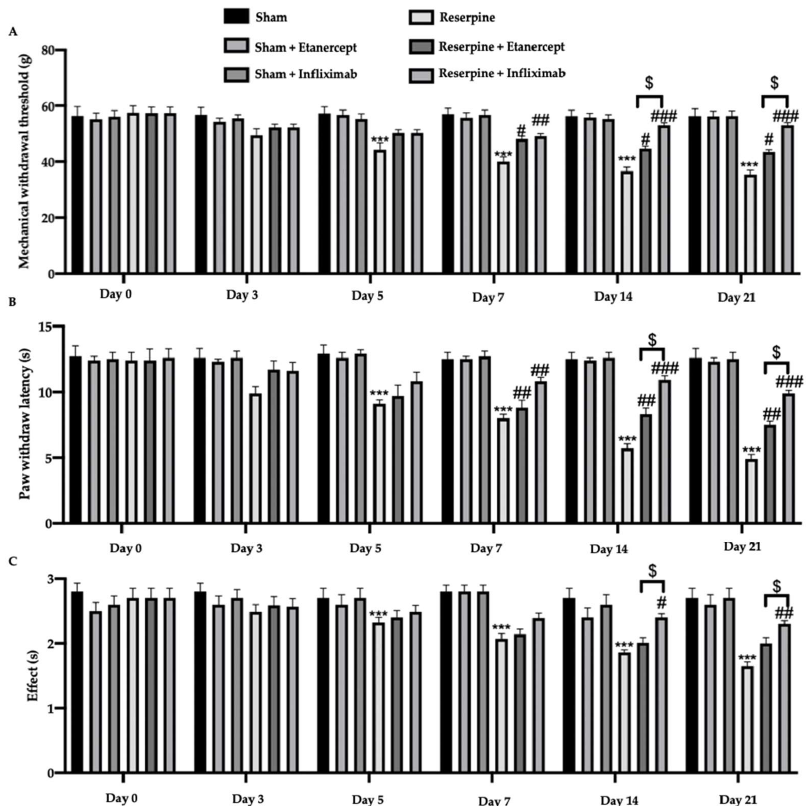
Figure 2. Efficacy of etanercept and infliximab administration on behavioural changes reserpine induced. Behavioural test: ( A ) Von Frey test, ( B ) hot plate test, ( C ) tail-flick test. For these analyses n = 5 animals for each group were employed. Repeated ANOVA analysis followed by a Bonferroni post-hoc test for multiple comparisons were employed to analyse the effect of treatments in reserpine model along time. A p -value <0.05 was considered significant. # p < 0.05 vs. vehicle, ## p < 0.01 vs. vehicle, *** p < 0.001 vs. sham, ### p < 0.001 vs. vehicle, $ p < 0.05 infliximab vs. etanercept.